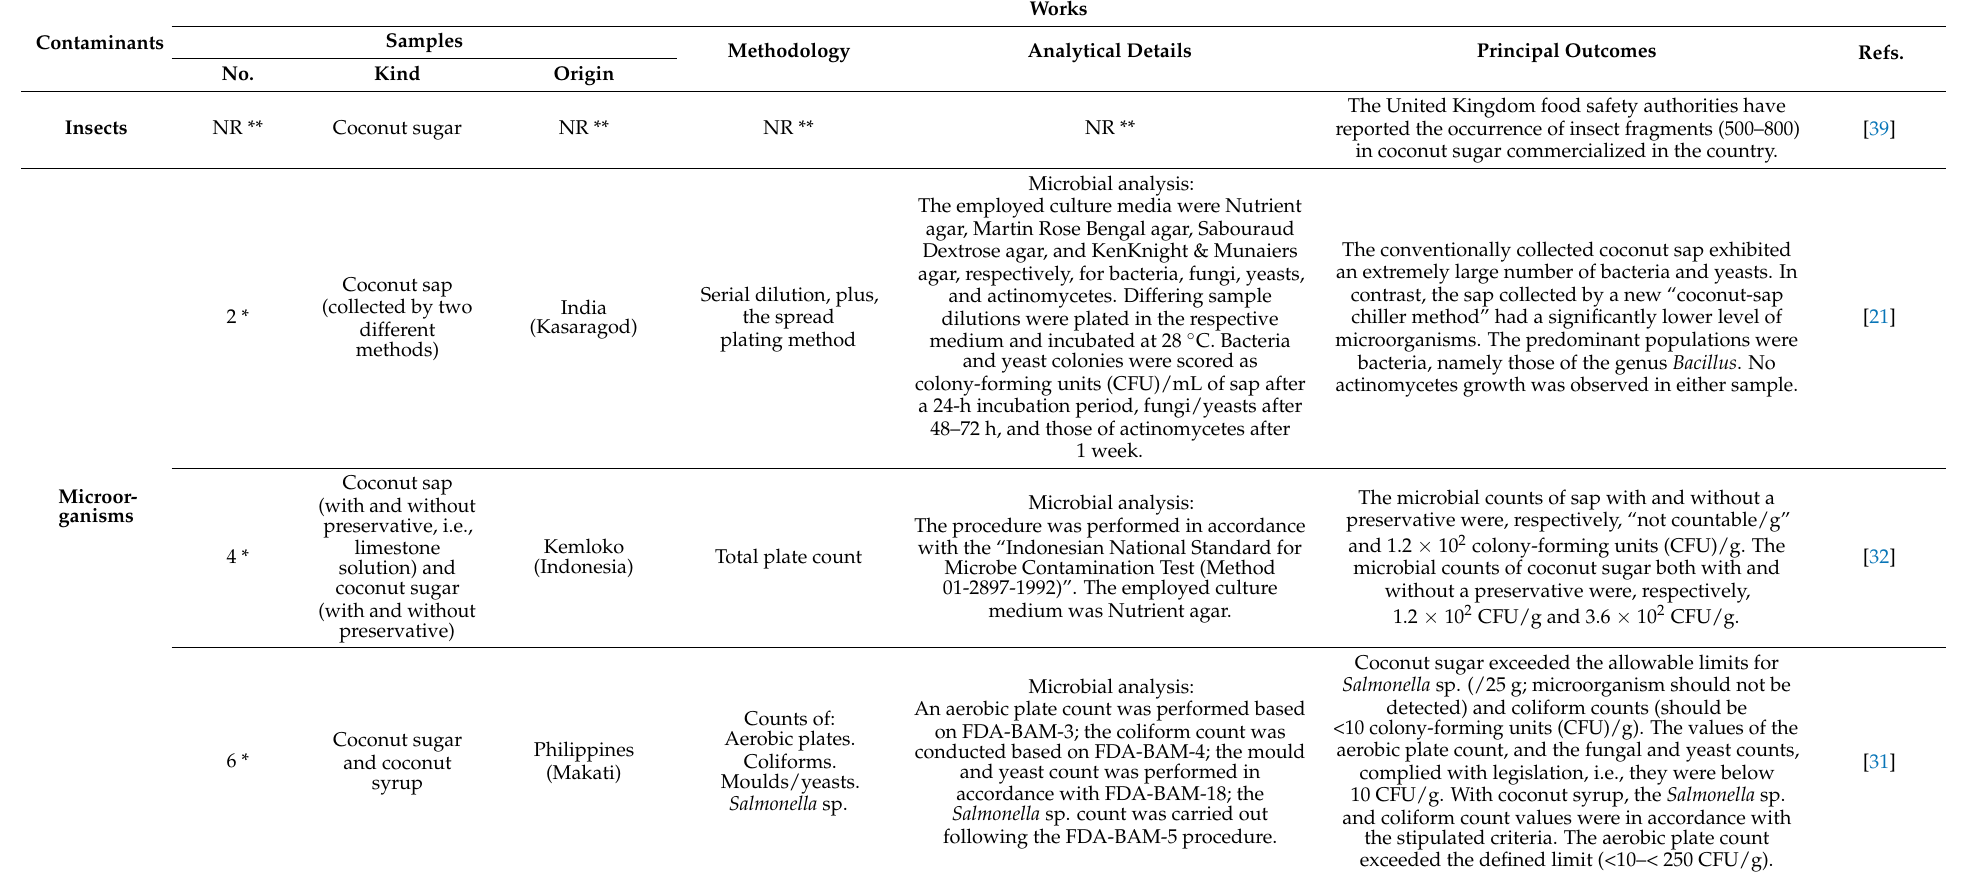
Table 4. Detecting contaminants in coconut sap, sugar, and